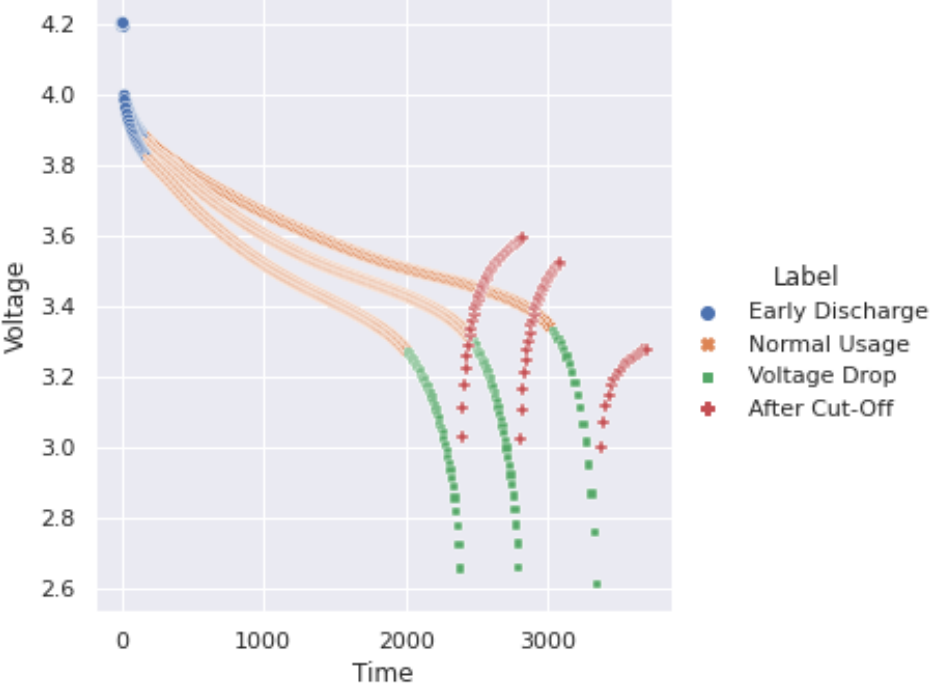
Figure 7. Comparison of voltage discharge profile at Cycle 1, 85, 169 of BAT0005 Cf. Figure